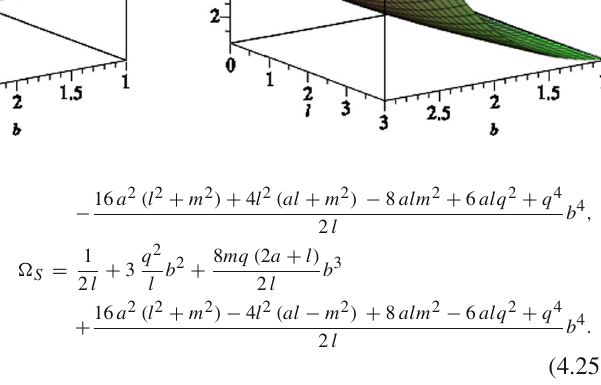
Fig. 16 The angular momentum of the black hole as function of a , b (left) and l , b (right), where we set the other black hole parameters to a set